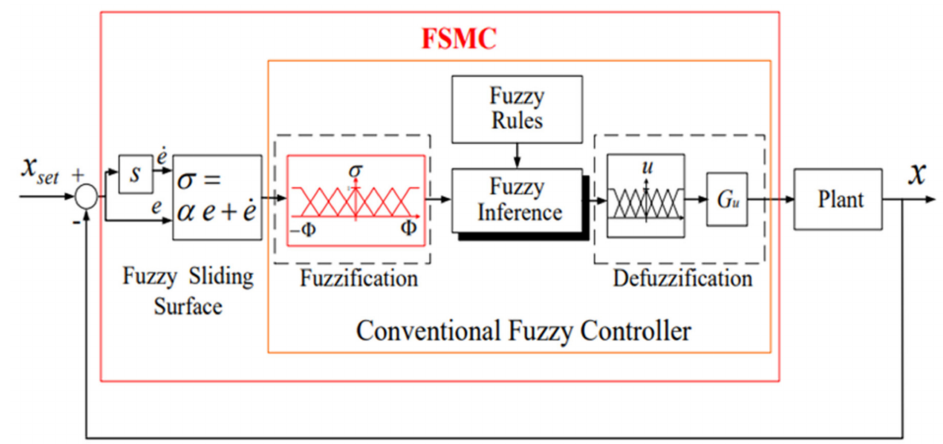
Figure 11. Fuzzy Sliding-Mode